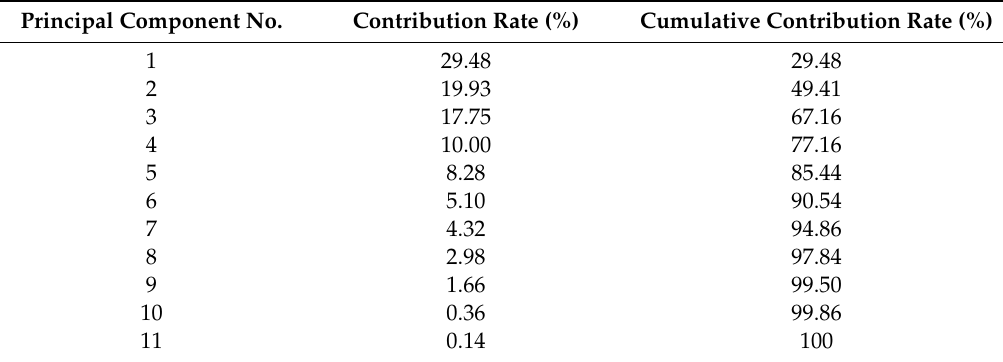
Table 7. Principal component analysis of the feature